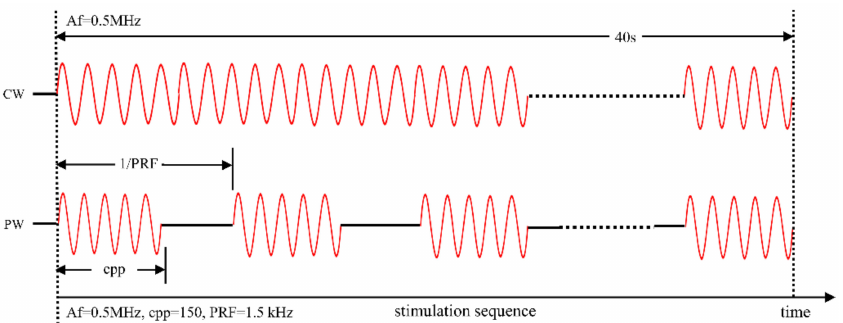
Figure 1. Ultrasound parameters. Pulsed ultrasound waveform (pw) and continuous ultrasound waveform (cw) generation with the following properties: Af = 0.5 MHz, c.p.p (cycles per pulse) = 150, PRF (pulse-repetition frequency) = 1.5 kHz; continuous ultrasound waveform generation with the following properties: Af = 0.5 MHz.